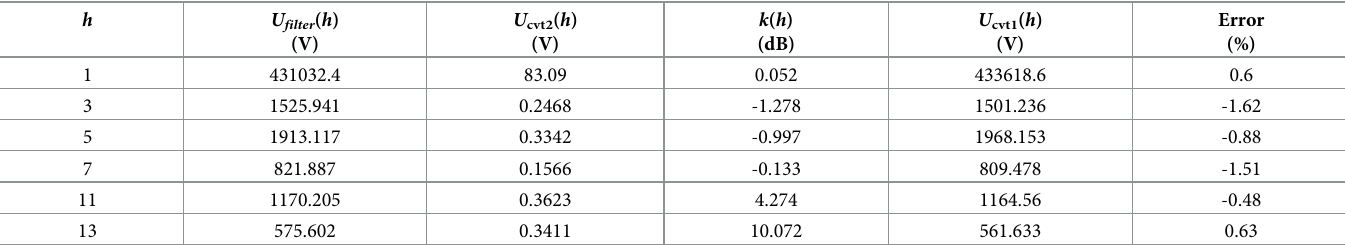
Table 13. Comparison of the RMS values of the individual harmonic voltages.